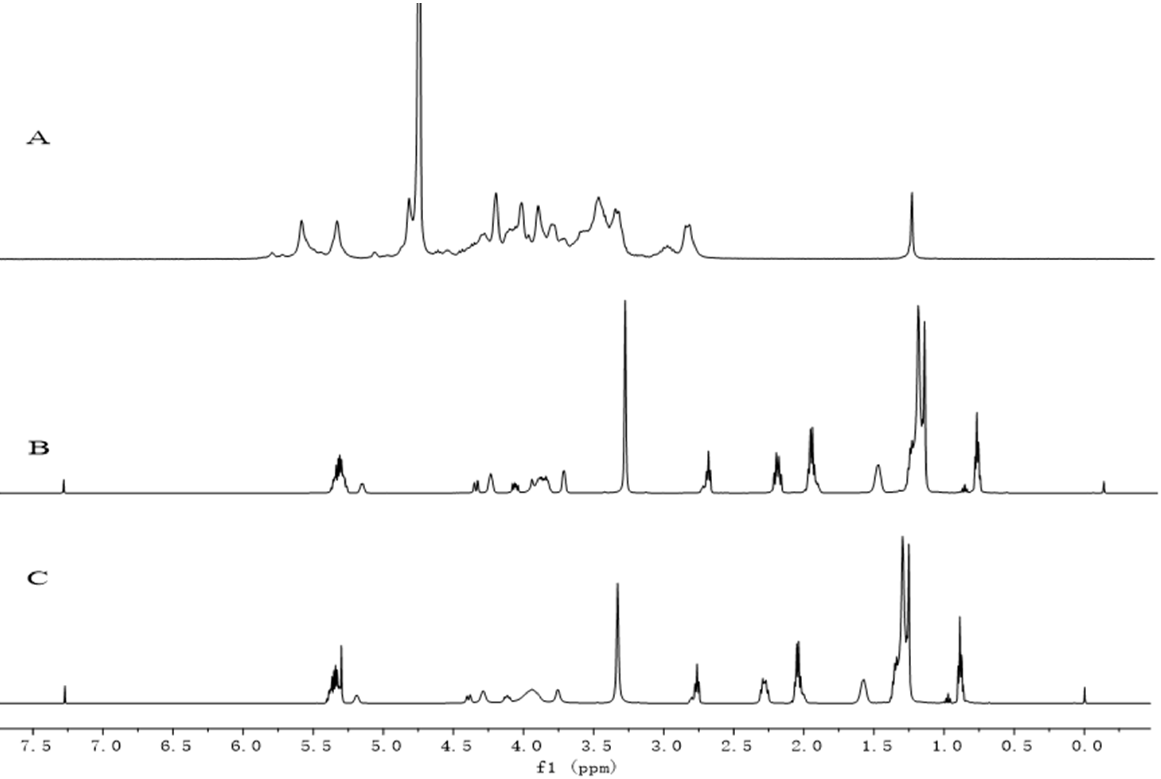
Figure 3. 1 H-NMR of ( A ) heparin (in D 2 O), ( B ) Pc (in CDCl 3 ), and ( C ) the HEP–Pc complex (in CDCl 3 ).